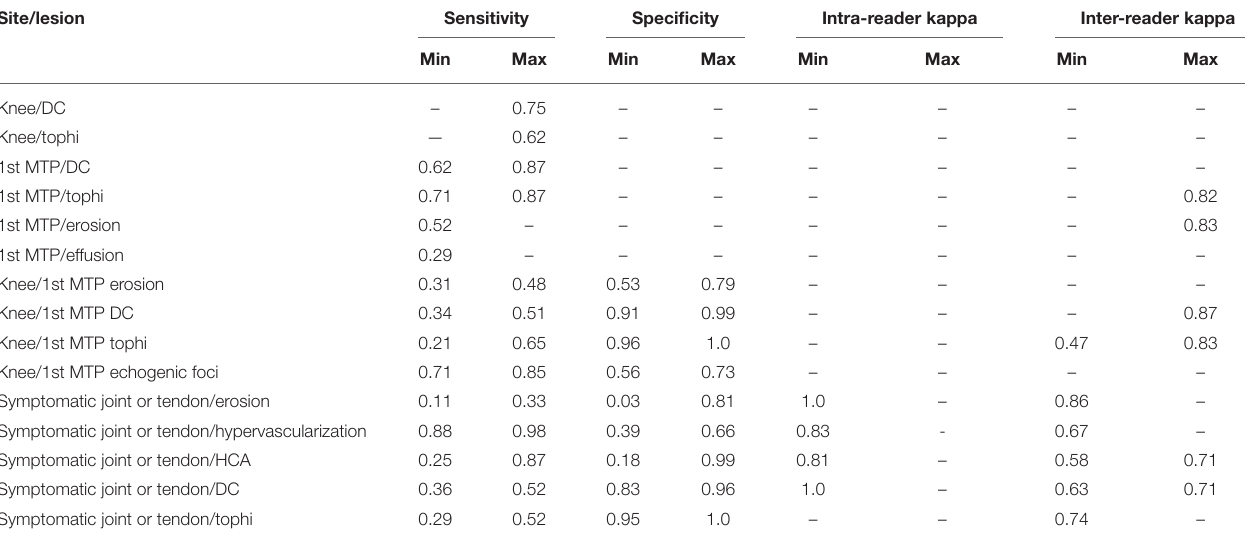
TABLE 9 | Performance of ultrasound to detect gout elementary lesions and reproducibility (acute attack). Site/lesion Sensitivity